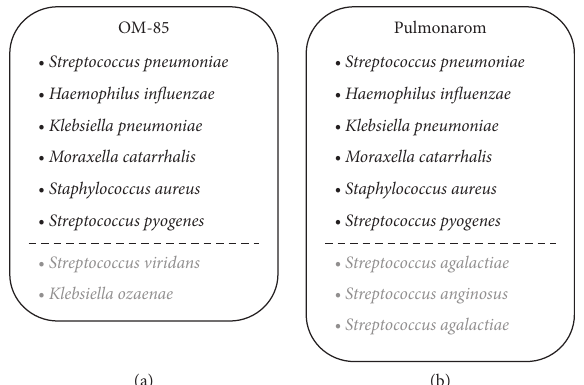
Figure 1: The composition of the two oral bacterial lysates. The composition of OM-85 differs from Pulmonarom. OM-85 contains Streptococcus viridans and Klebsiella ozaenae , instead of Streptococcus agalactiae , Streptococcus dysgalactiae , and Streptococcus anginosus